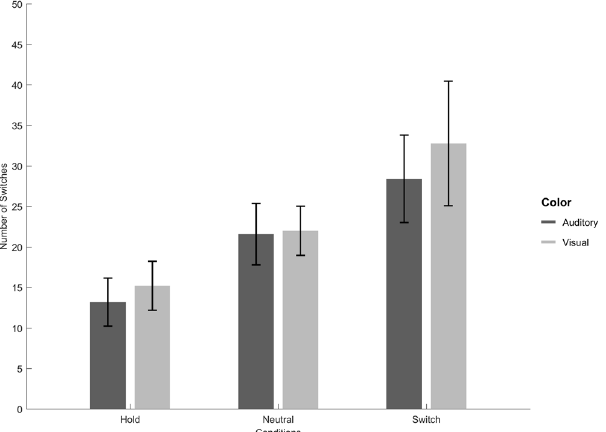
Figure 1. Mean number of perceptual switches during a 180-second block in each condition and modality. Error bars indicate 95% confidence intervals.